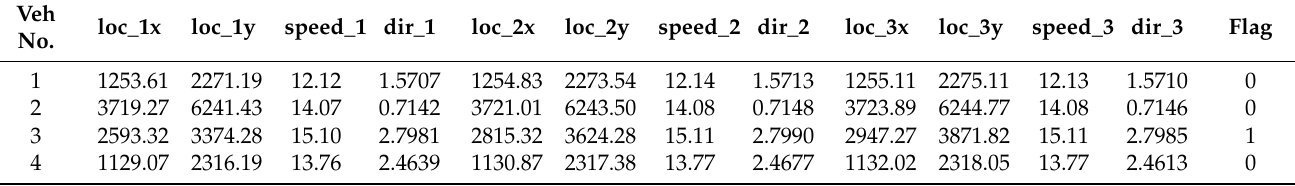
Table 3. Brief overview of the dataset used for anomaly